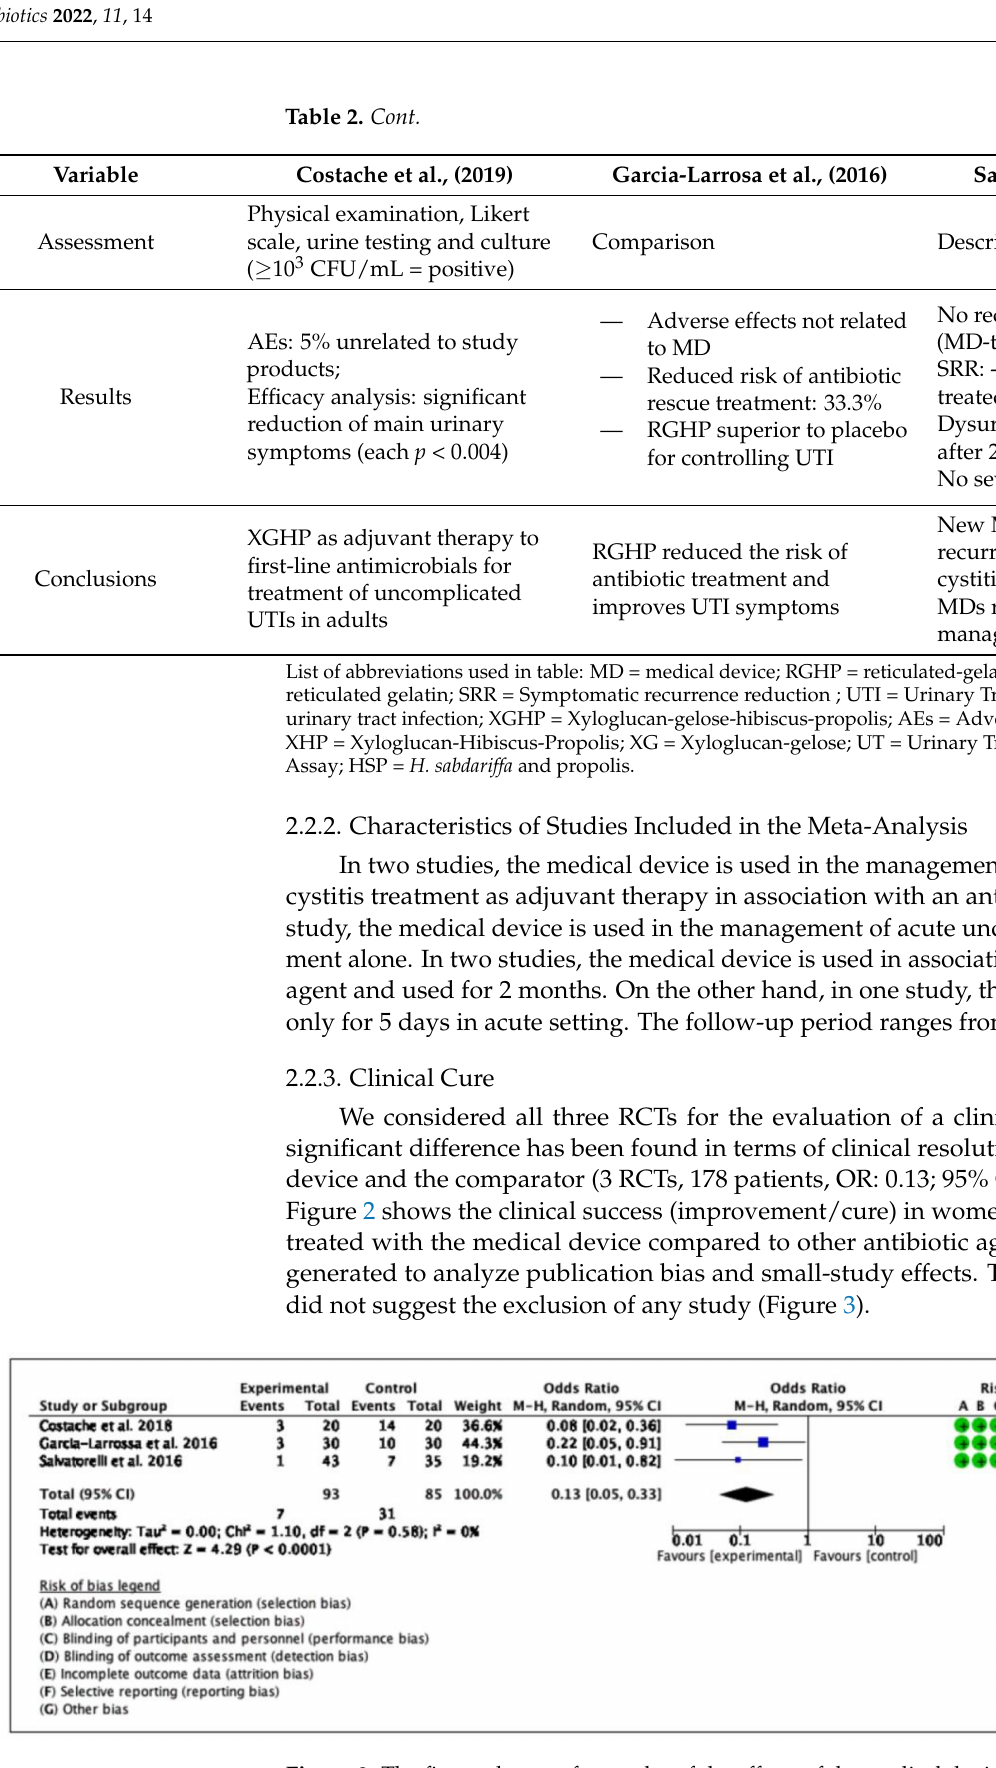
Figure 2. The figure shows a forest plot of the effects of the medical device on women with cystitis in terms of clinical success